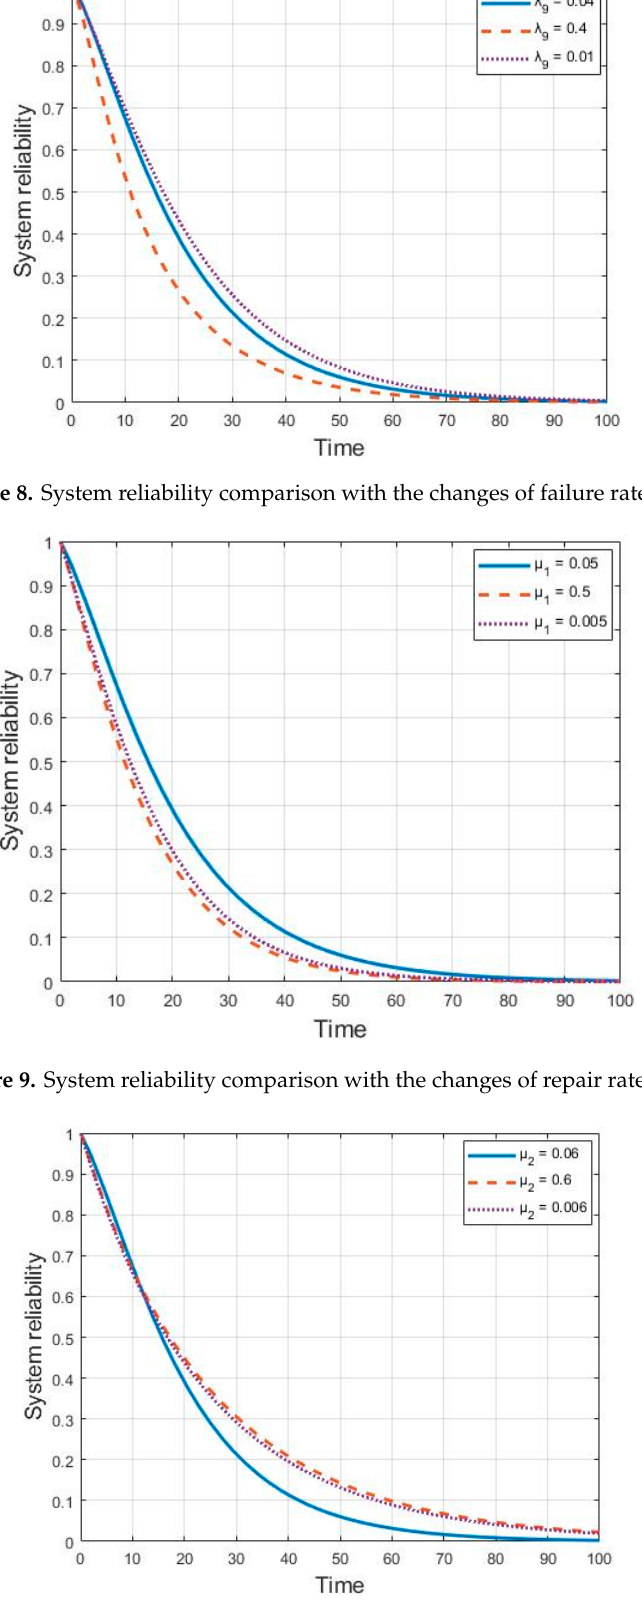
Figure 10. System reliability comparison with the changes of repair rate µ 2